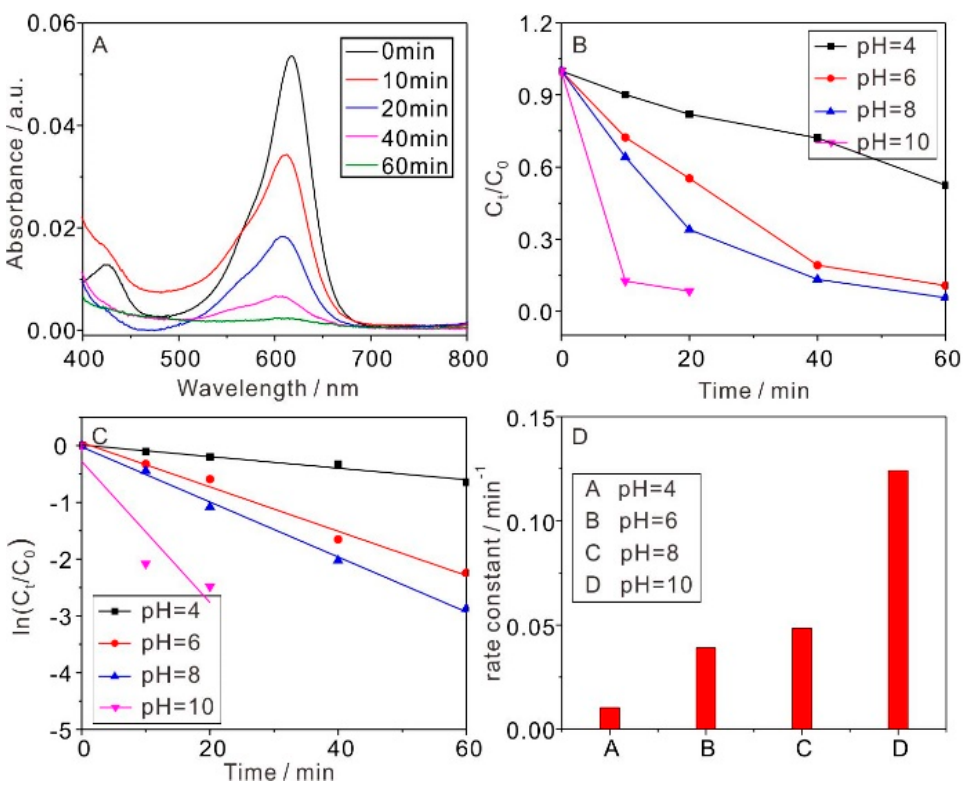
Figure 5. ( A ) Time-course UV-Vis absorbance spectra of MG (10 − 5 M) photocatalyzed by 0.6 g/L TiO 2 under UV light at pH = 8. ( B – D ) The calculated time-dependent ratios of C t / C 0 , first-order degradation rates and reaction rate constants for MG (10 − 5 M) photocatalyzed by 0.6 g/L TiO 2 with different pH values.